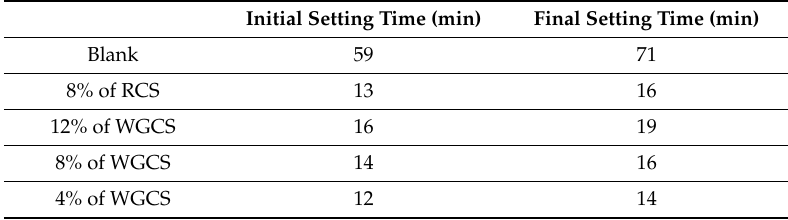
Table 4. Setting time of CS–CSA pastes (maximum error was 2